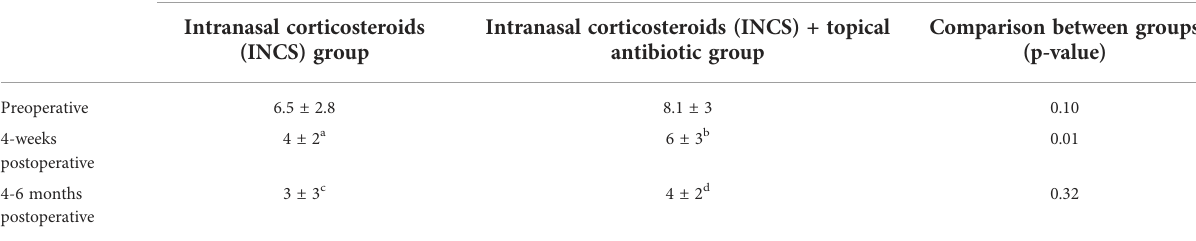
TABLE 3 Changes over time on Lund-Kennedy endoscopic score (LKS) in the control and intervention groups (mean, S.D.).